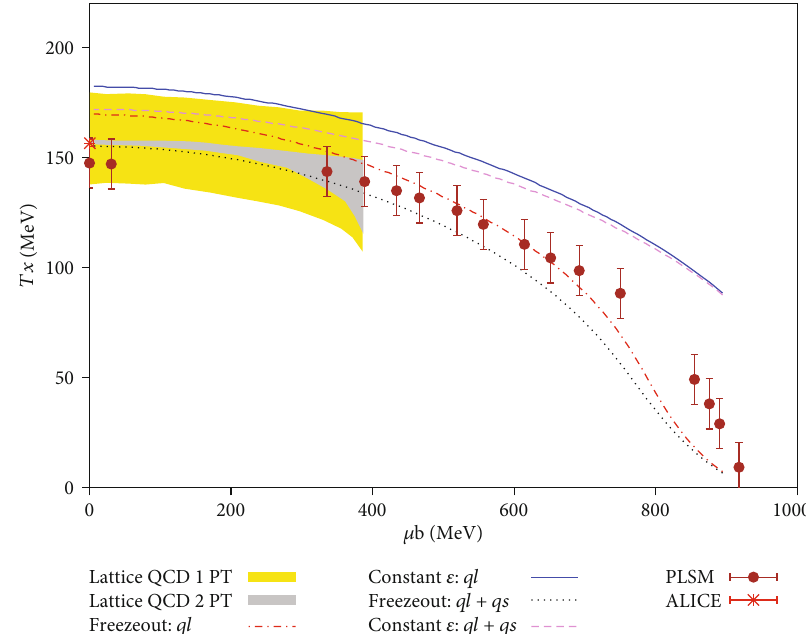
Figure 2: The same as in Figure 1, but here there is a comparison between lattice QCD simulations [61, 62] and the Polyakov linear-sigma model [63, 65 – 70] with the thermal